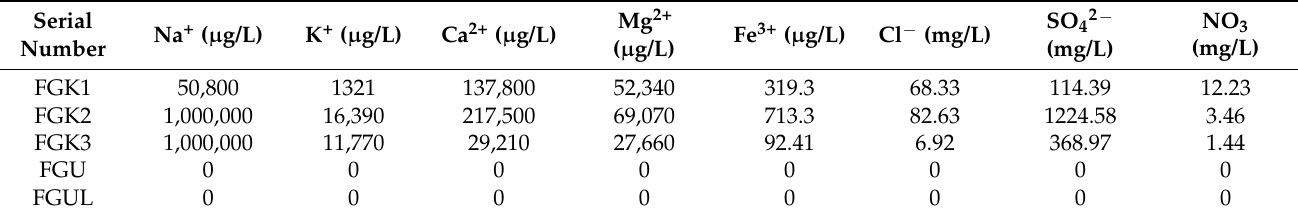
Table 2. Initial Hydro-chemical Composition of Different Immersion